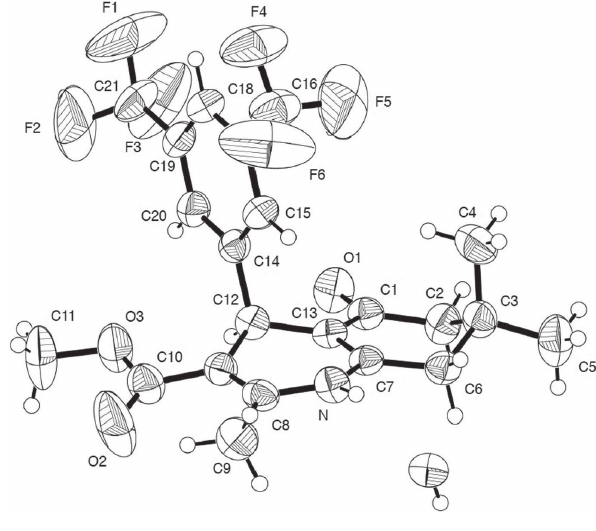
Table 1: Data collection and handling.